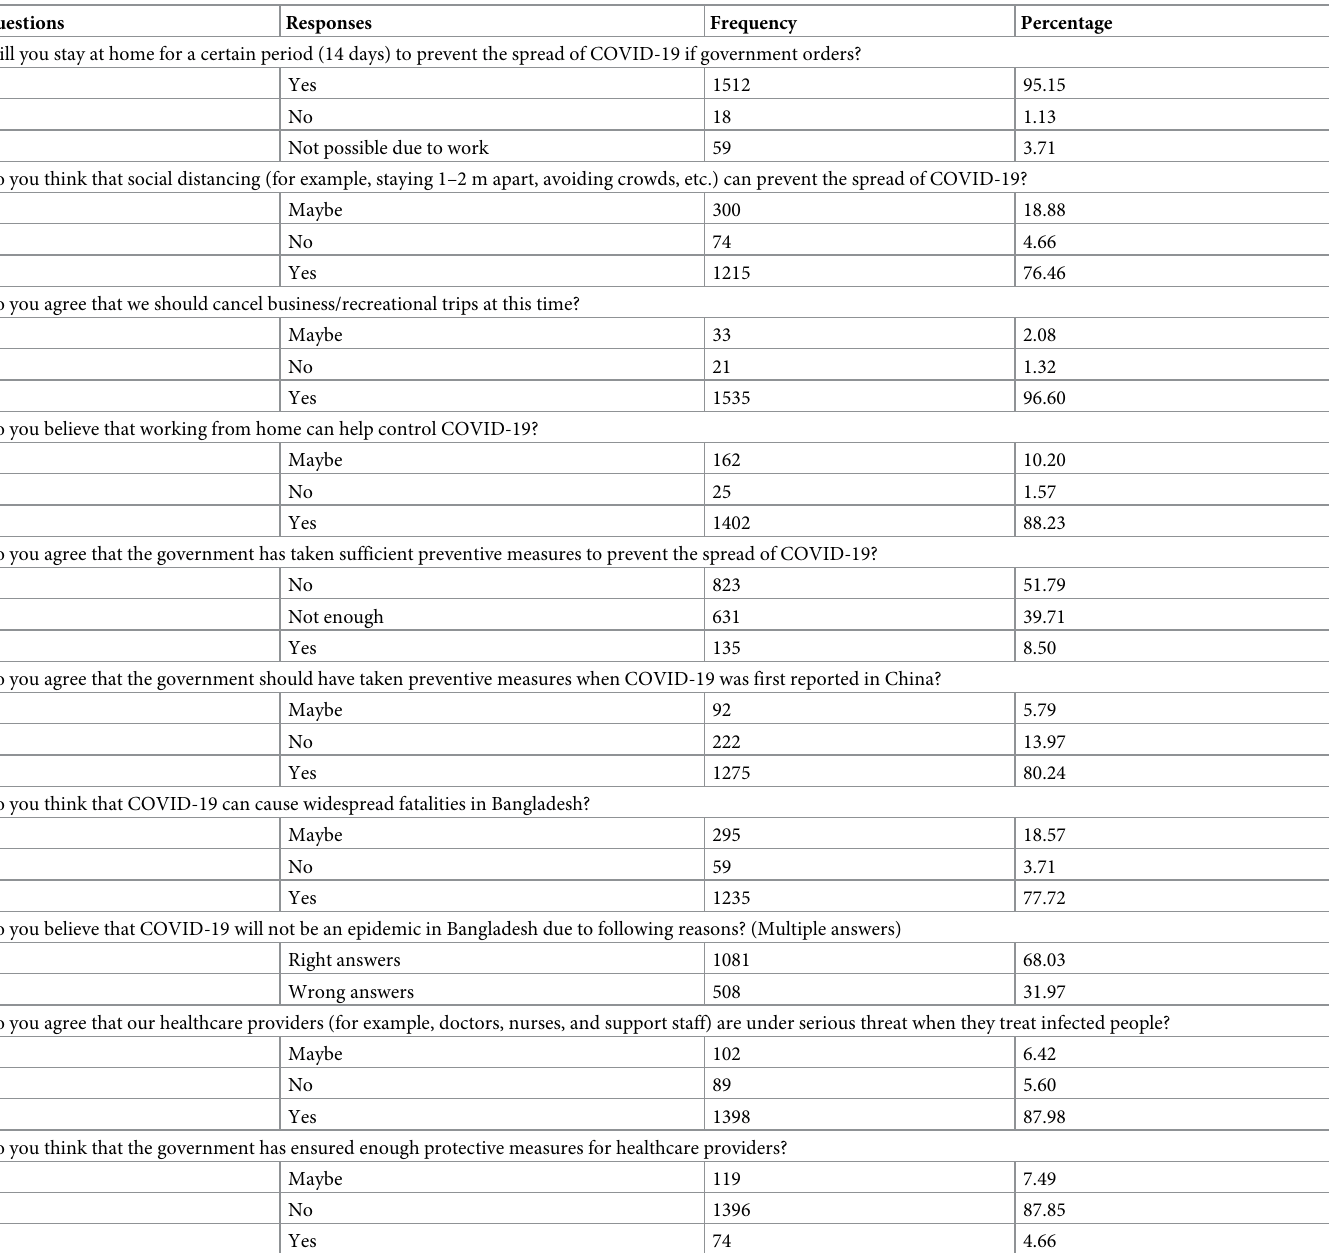
Table 4. Frequency distribution of the responses to attitude